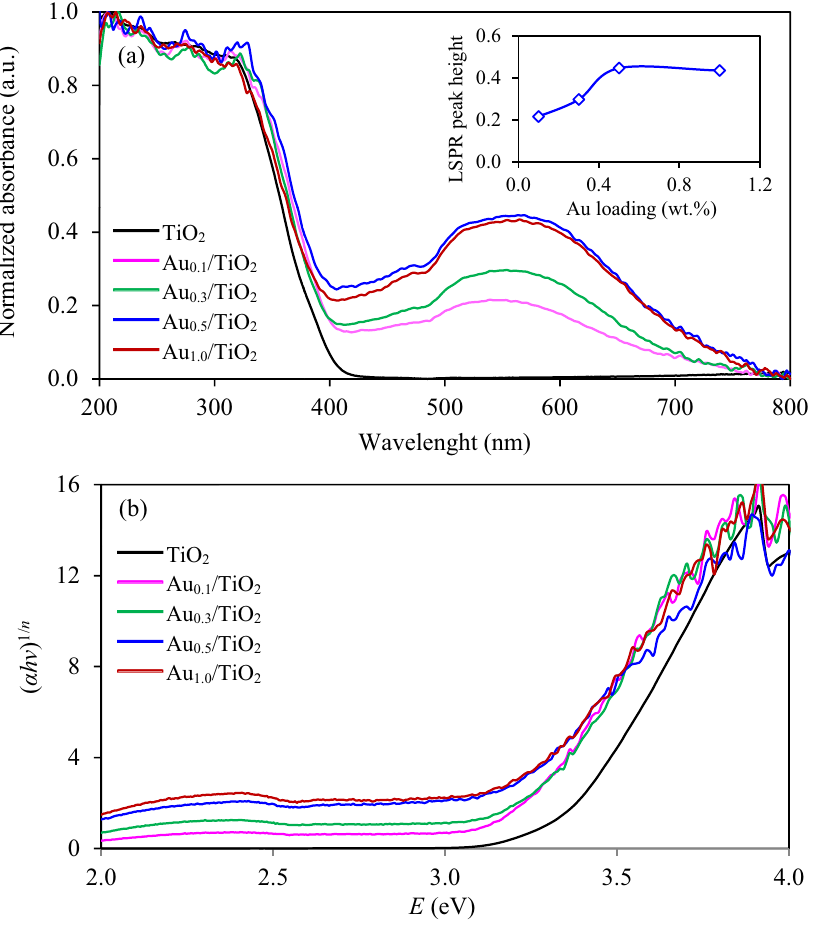
Figure 7. ( a ) UV–Vis absorption spectra and ( b ) Tauc’s plots of commercial TiO 2 and Au x /TiO 2 NPs synthesized by photodeposition at different gold loadings in the range of 0.1–1.0